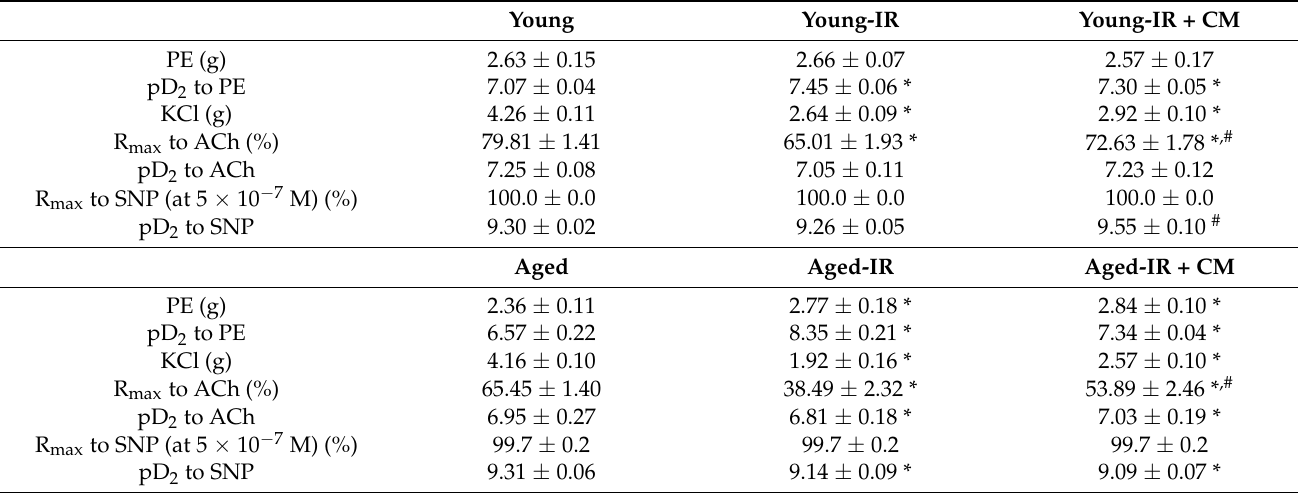
Table 2. Quantitative analysis of aortic vascular function after treatment with conditioned medium (CM) from bone marrow-derived mesenchymal stem cells against ischemia/reperfusion (IR) injury in young and aged aortic